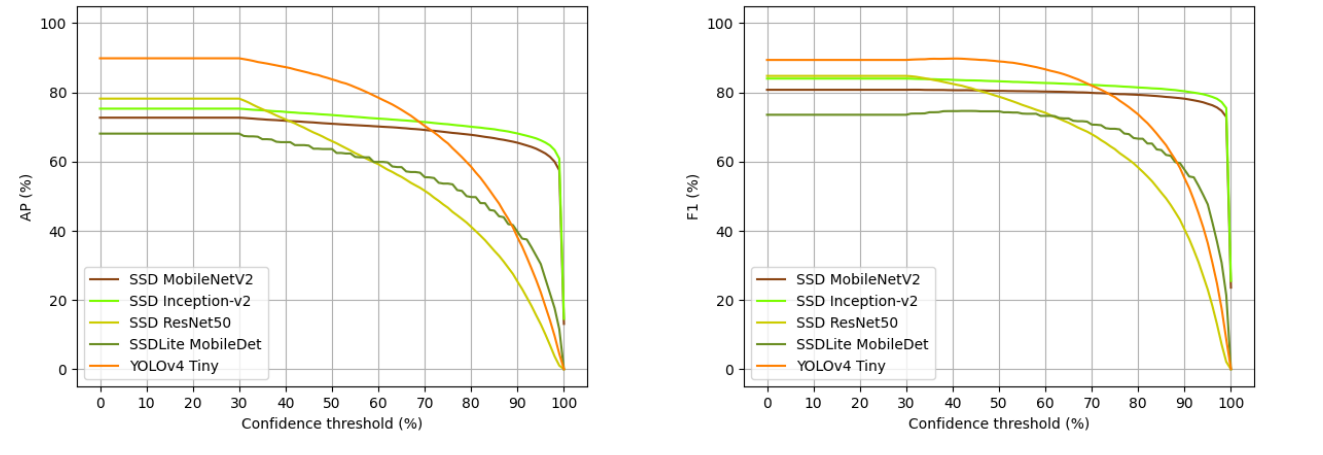
Figure 6. Results of the evolution of AP ( a ) and F1 ( b ) metrics over the full range of confidence levels.